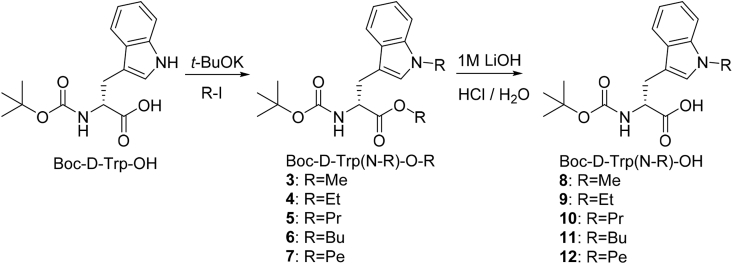
Synthesis of the carboxylic acid derivatives of Nind-alkylated Boc-D-Tryptophan (8–12).